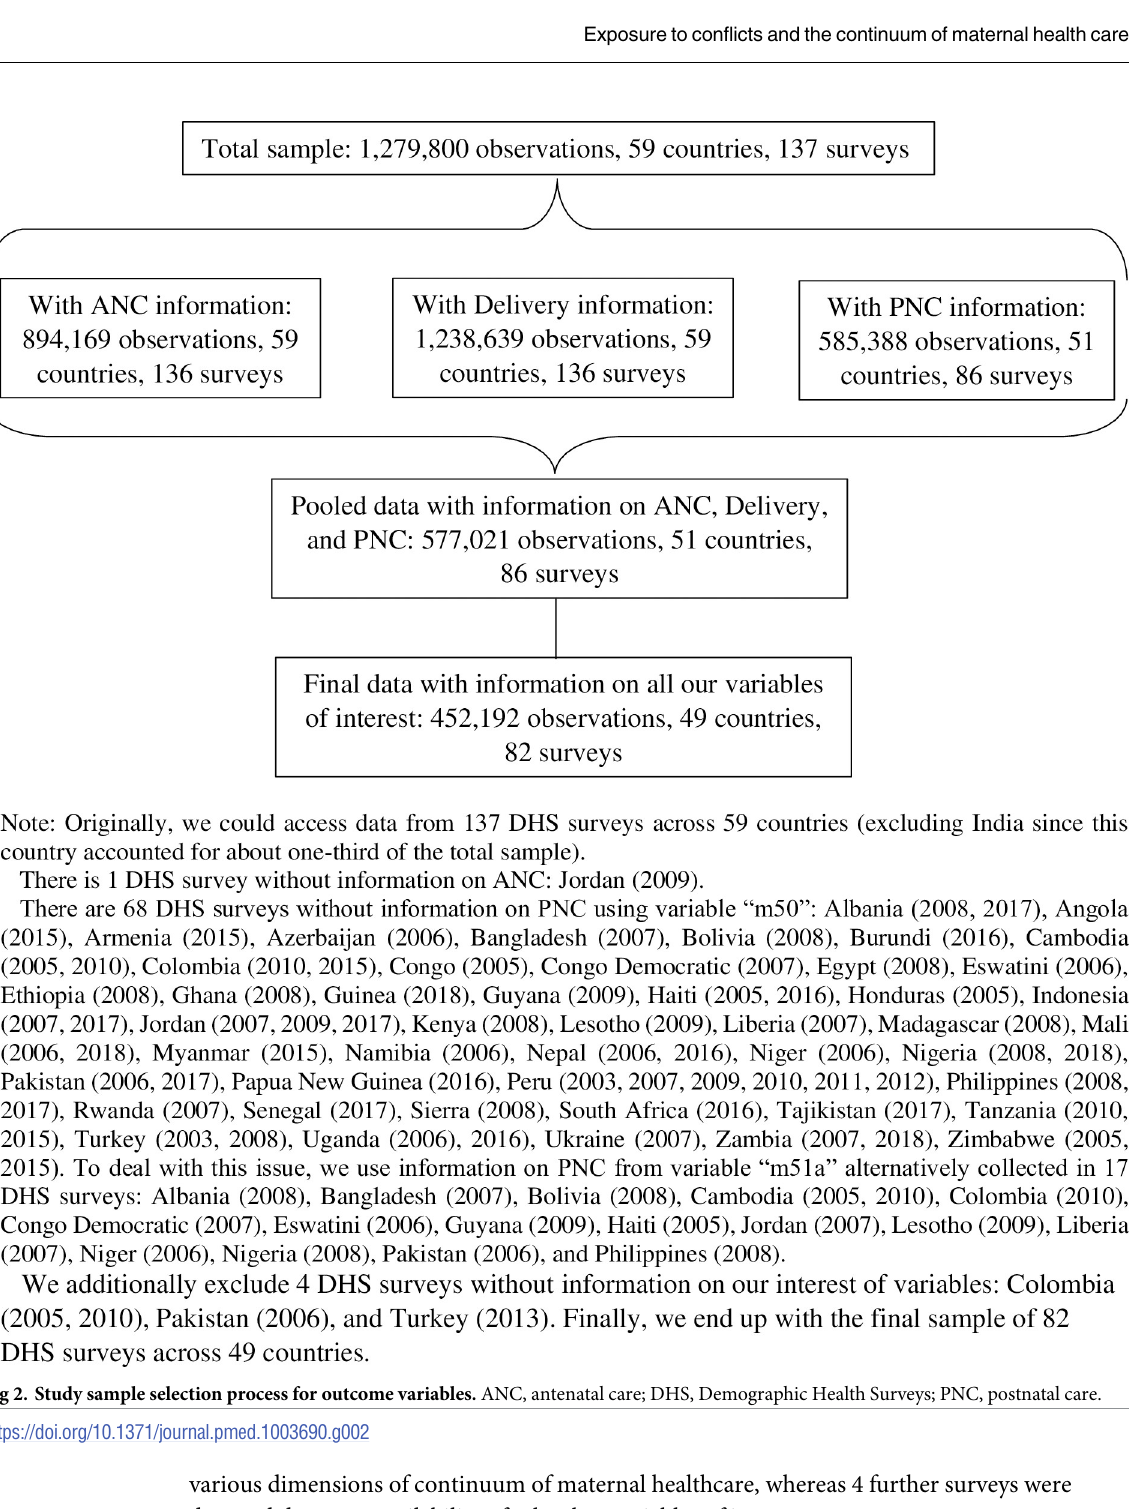
Fig 2. Study sample selection process for outcome variables. ANC, antenatal care; DHS, Demographic Health Surveys; PNC, postnatal care.